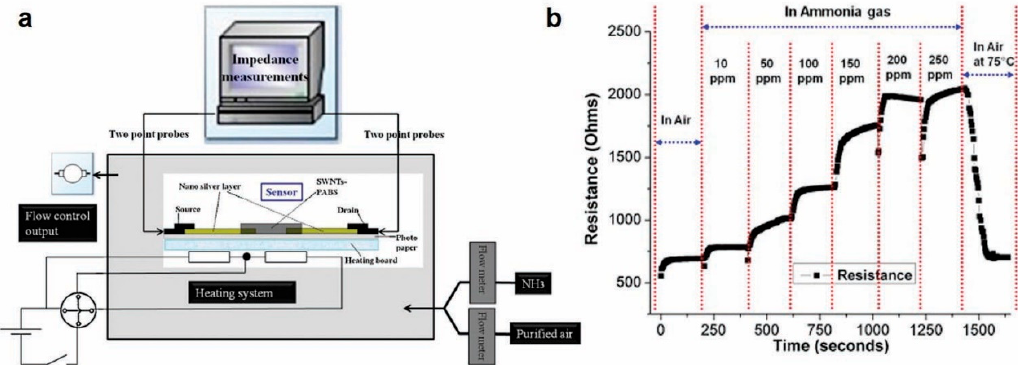
Figure 7. ( a ) Measurement setup for paper-based sensors with silver and inkjet-printed SWNT-PABS. ( b ) Resistance of paper-based sensor exposed to different concentrations of NH 3 . Reproduced with permission from Elsevier [54].